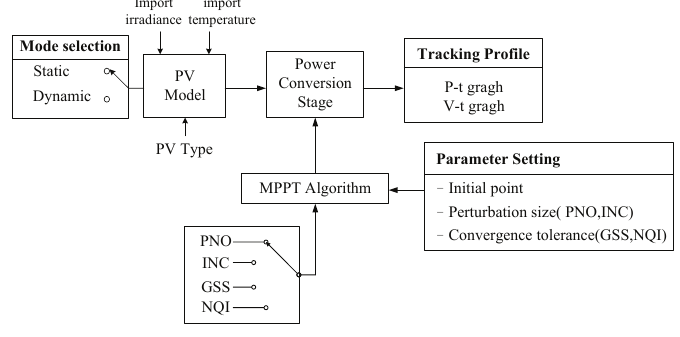
Figure 10. Matlab testing